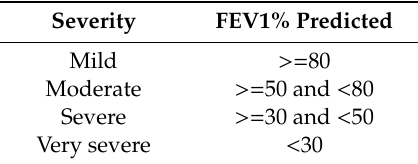
Table 1. COPD Severity Ranges.